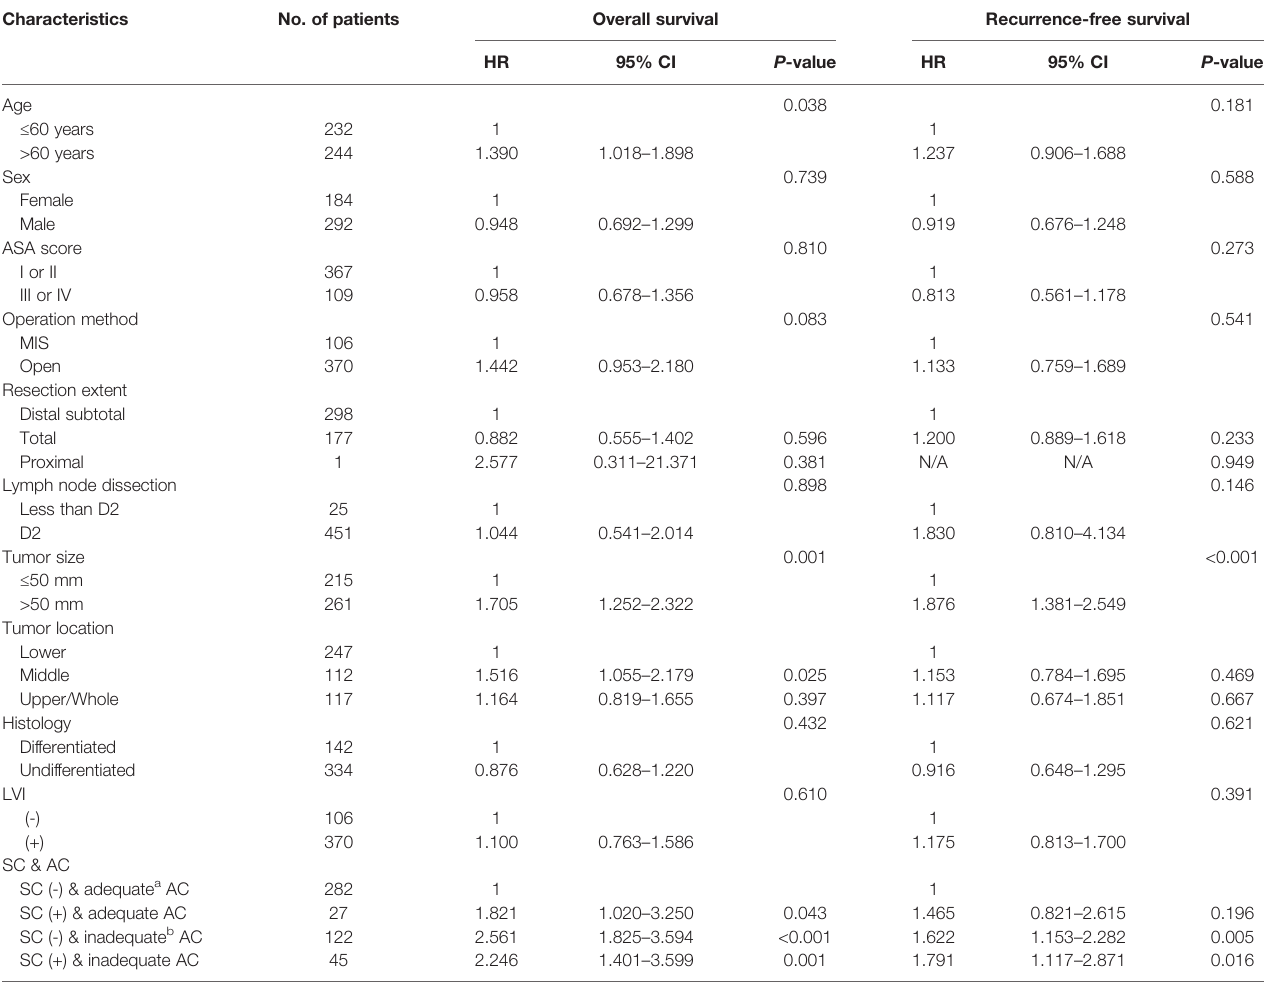
TABLE 5 | Multivariate analyses of overall and recurrence-free survival in stage III gastric cancer patients. Characteristics